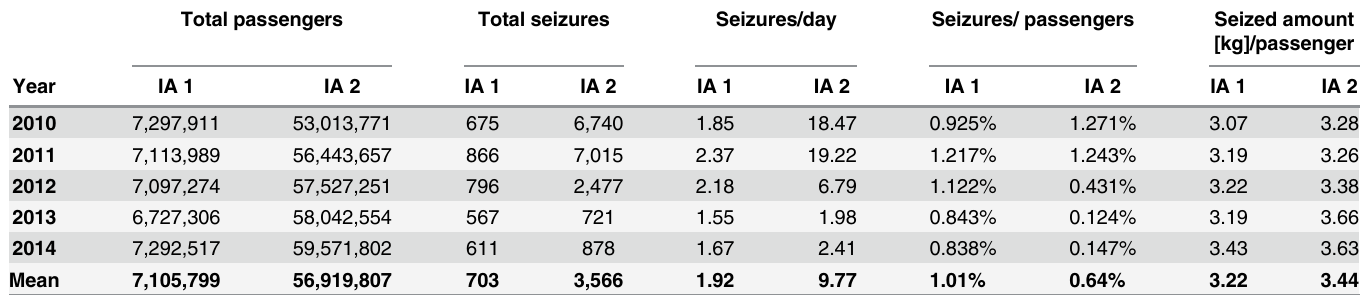
Table 1. Total passengers, total seizures, seizures/day, seizure-passenger ratio and mean seized amount in kilogrammes per passenger at IA 1 and IA 2, 2010 – 2014. Total